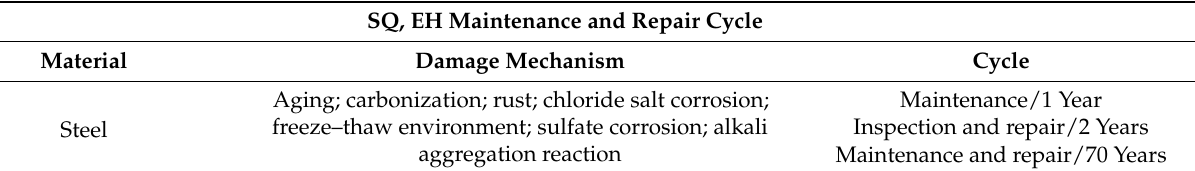
Table 3. Maintenance and repair